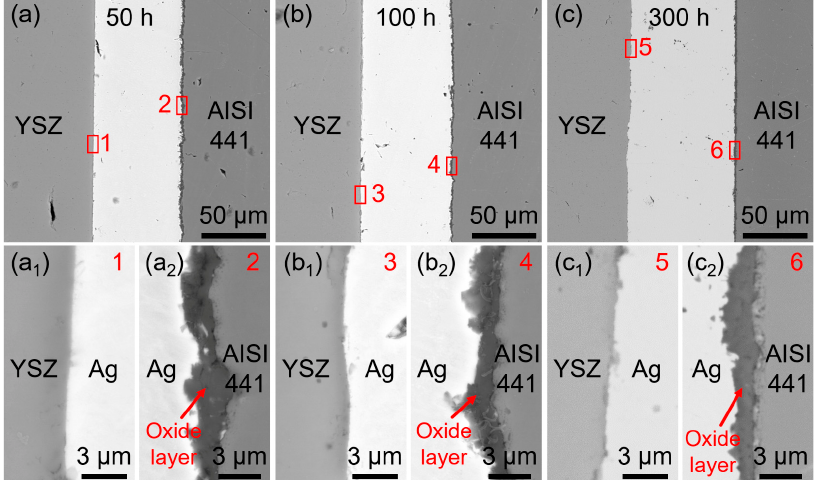
Figure 7. Microstructure of the joints after aging in 50% (H 2 + Ar) − 50% H 2 O at 800 °C for ( a ) 50 h, ( b ) 100 h, and ( c ) 300 h, respectively. ( a 1 – c 1 ) are enlarged views of the YSZ interface, ( a 2 – c 2 ) are enlarged views of the AISI 441 interface).